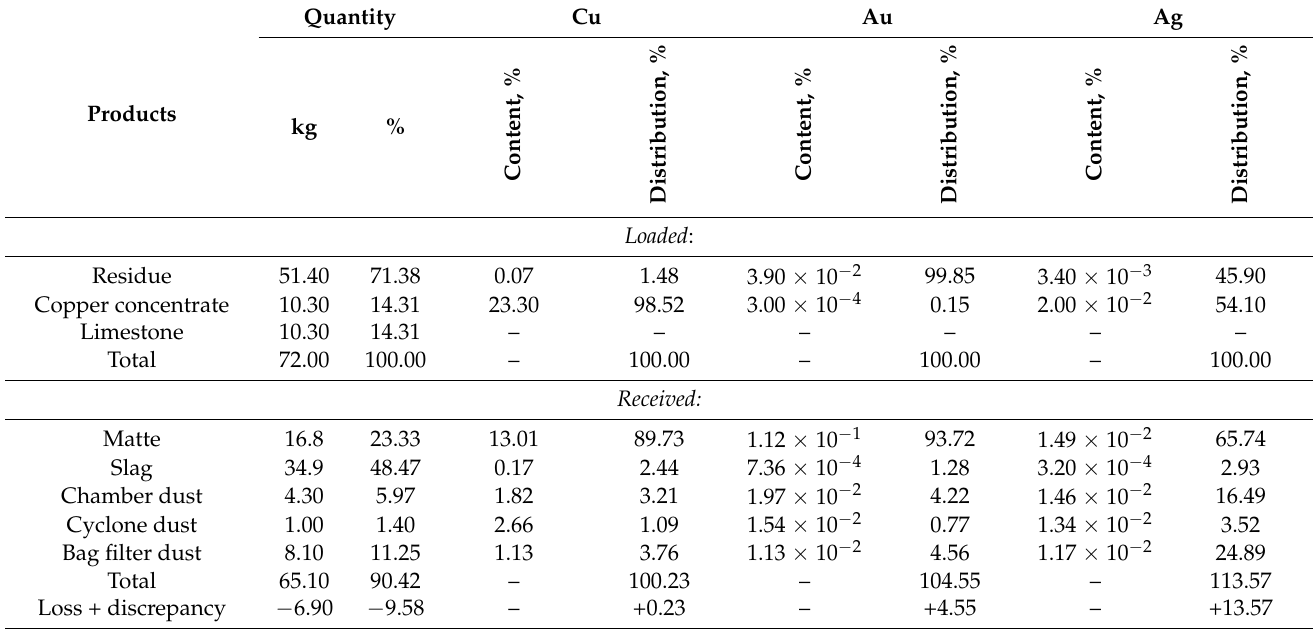
Table 4. Metal distribution during cyclonic smelting of arsenic sublimation residue from Bakyrchik gravity